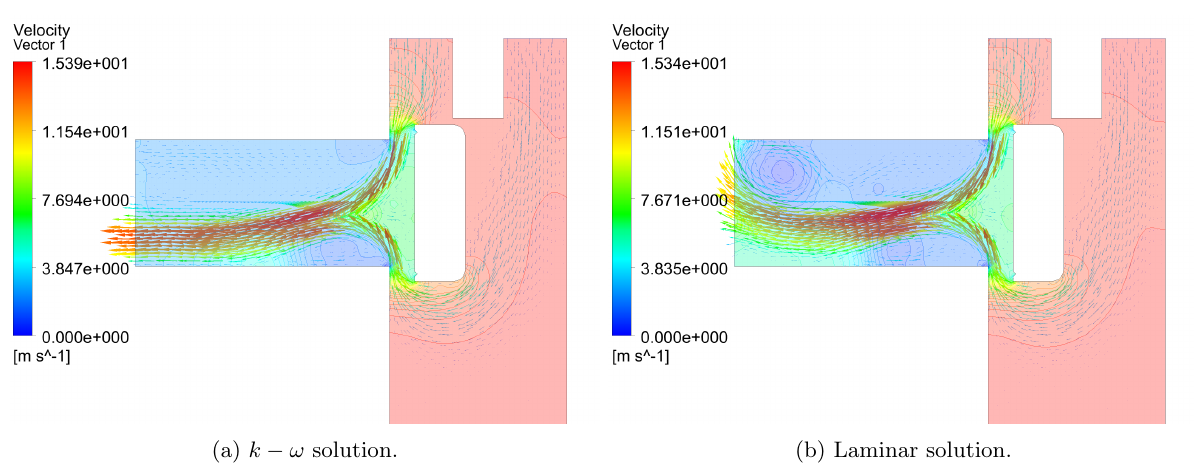
Figure 6: One sample of the spatial pressure solutions as contours and velocity field as vector of magnitude and direction for the fluid flow problem. z = 1 mm, BC1 = 6 bar and BC2 = 5 bar and two different solvers have been used.